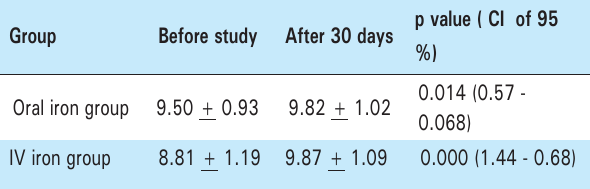
Table 2. Hemoglobin increment after 30 days